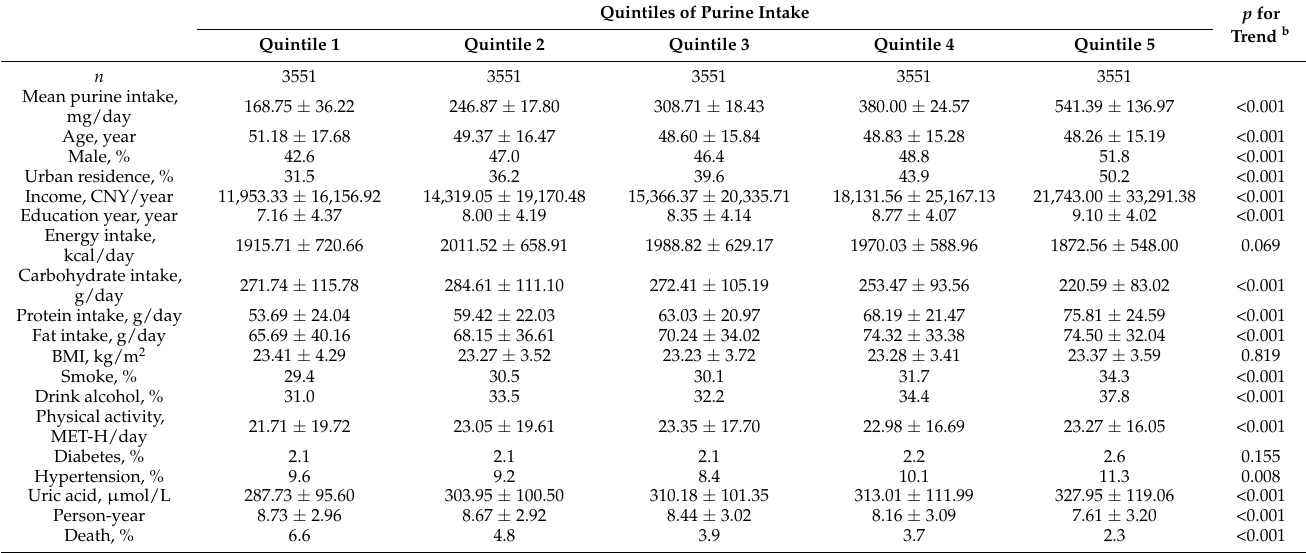
Table 1. Baseline characteristics of participants by quintiles of purine intake ( n = 17,755) a .